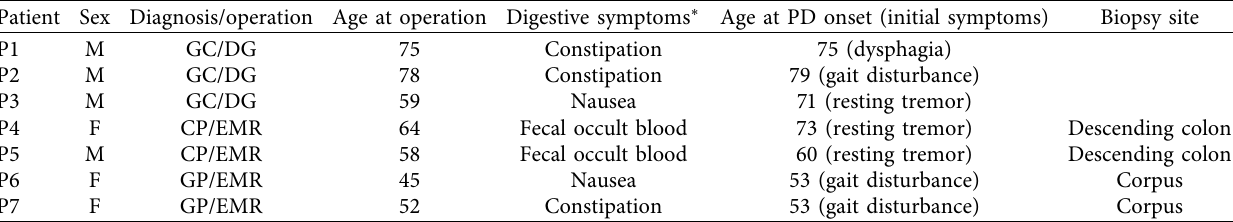
Table 1: Clinical profiles of PD patients.